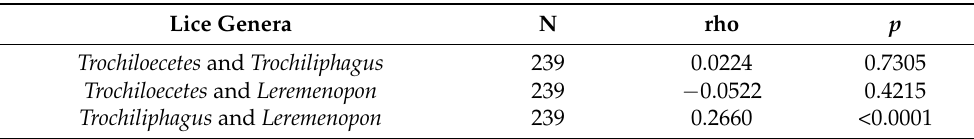
Table 3. Spearman rank correlations between the prevalence of pairs of louse genera across 239 host taxa (N ≥ 50 individuals) of hummingbirds.